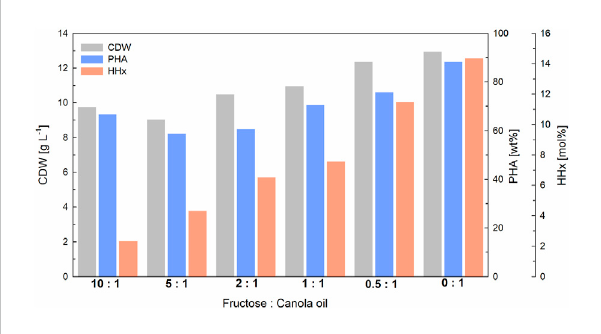
FIGURE 4 Final yields of 1-L bioreactor cultivations for tailor-made P(HB- co -HHx) production with R. eutropha Re2058/pCB113 using fructose and canola oil mixtures as carbon source and urea as nitrogen source. Cell dry weight (CDW; g L − 1 ), PHA content of CDW (PHA; wt%) and HHx content of PHA (HHx; mol%) after 72 h are shown for each mixture with a fi nal carbon content of 10 g L − 1 and a C/N ratio of 22 g g − 1 . The carbon ratio of fructose to canola oil (g g − 1 ) is indicated for each